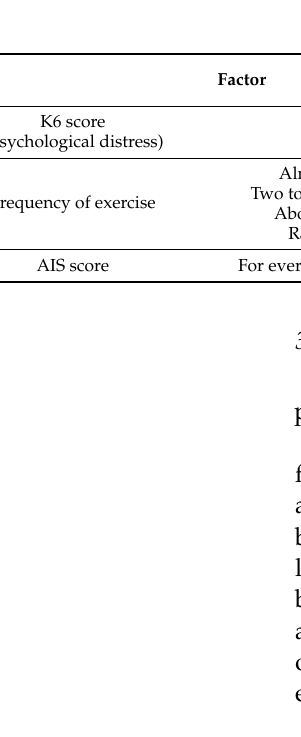
Table 5. Logistic regression analysis of the dependent variables for social nonparticipation in the activities of daily living (ADL) independent